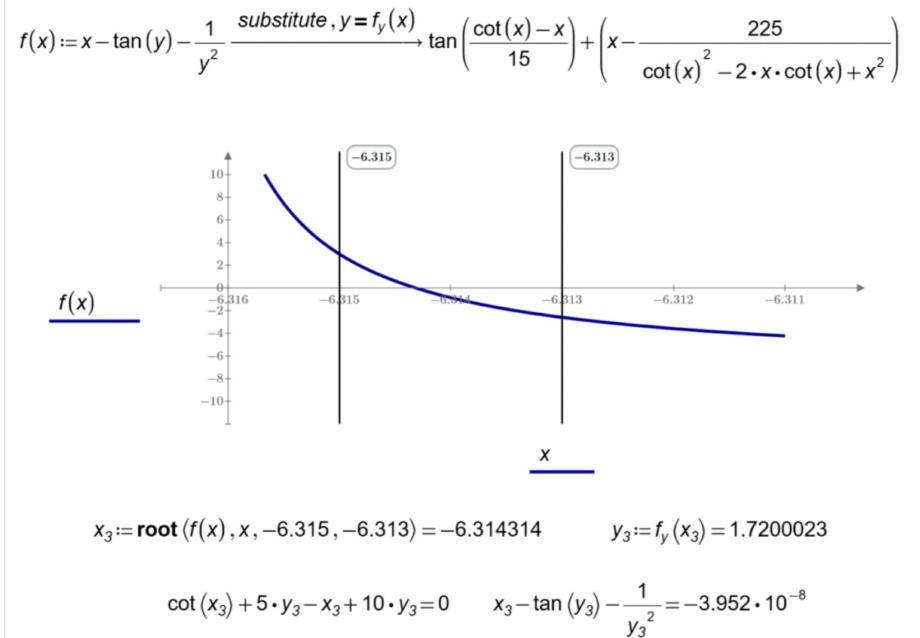
Figure 8. Finding the solution of system (1) with the help of the function